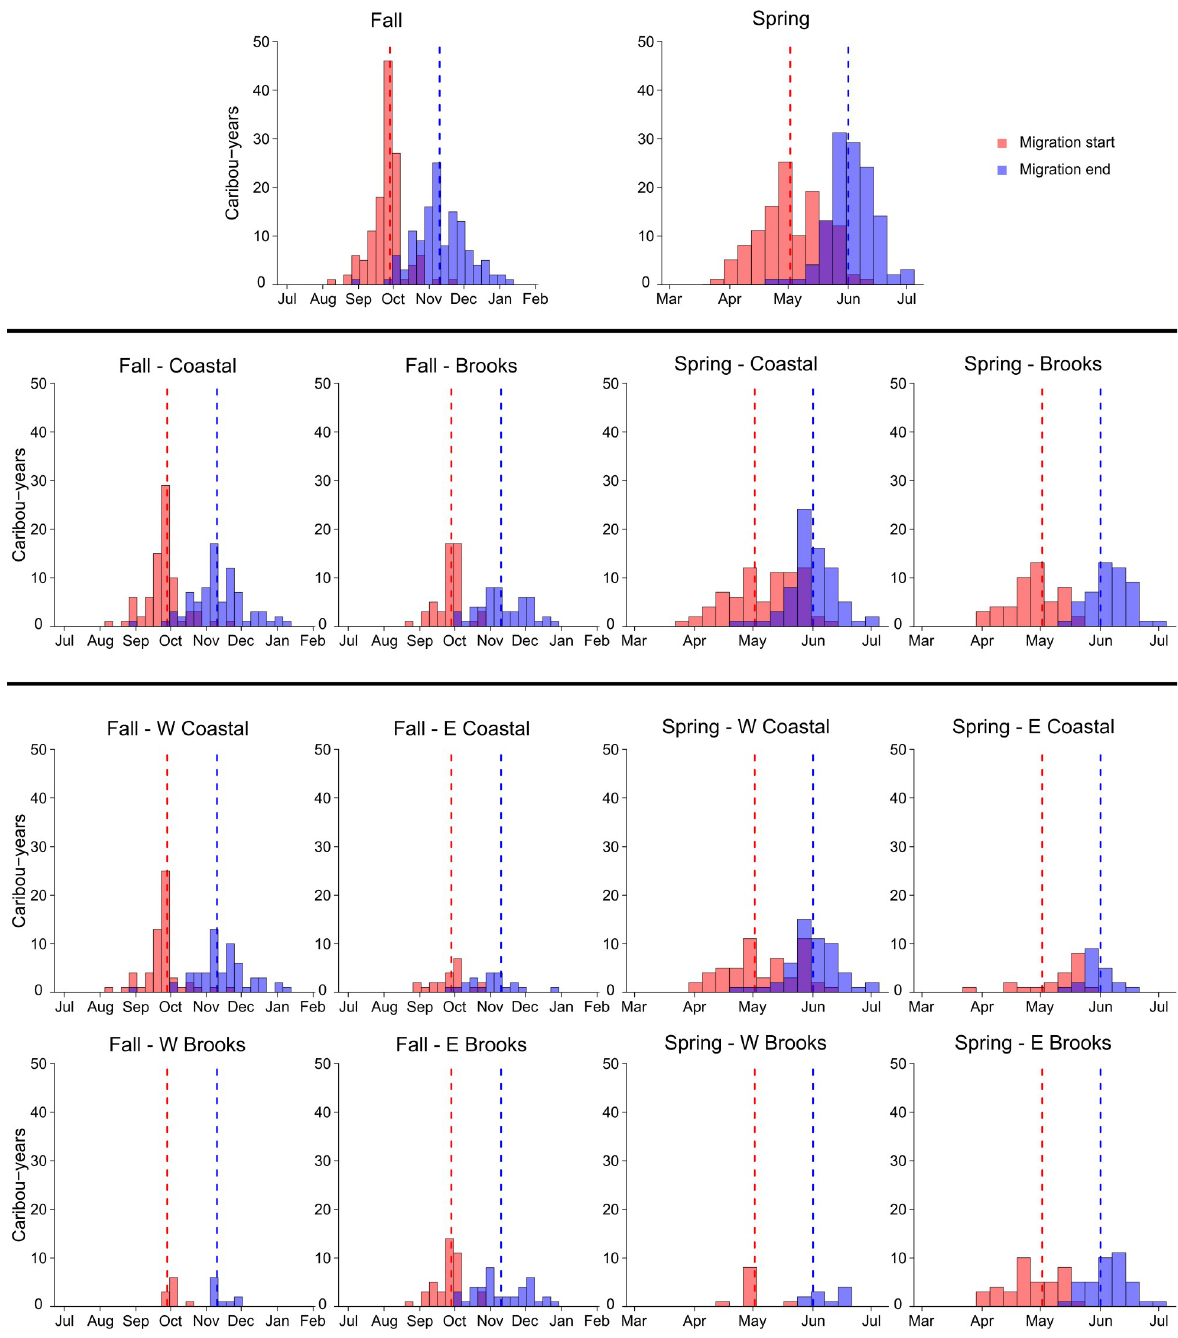
Fig 2. Migration start and end dates by season. Data shown combined for all caribou-years (top row), divided at a coarse scale–coastal plain versus Brooks Range (second row), and divided at a fine scale–four wintering areas (bottom two rows). Bars in each panel represent one-week intervals. Vertical dashed lines indicate median migration start (red) and end (blue) dates, as reported in this study (Table 1). Data are depicted for caribou- years classified as “migration” (n = 129) by the first passage time–net squared displacement method.